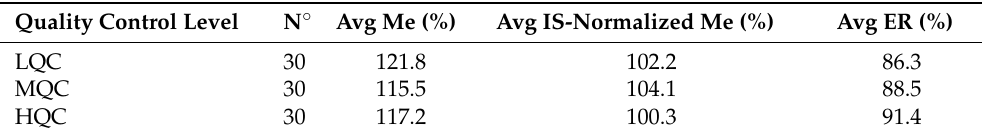
Table 5. Average (Avg) Matrix Effect (ME%) and Extraction Recovery (ER%) of MRP measured at different concentration levels for MRP.